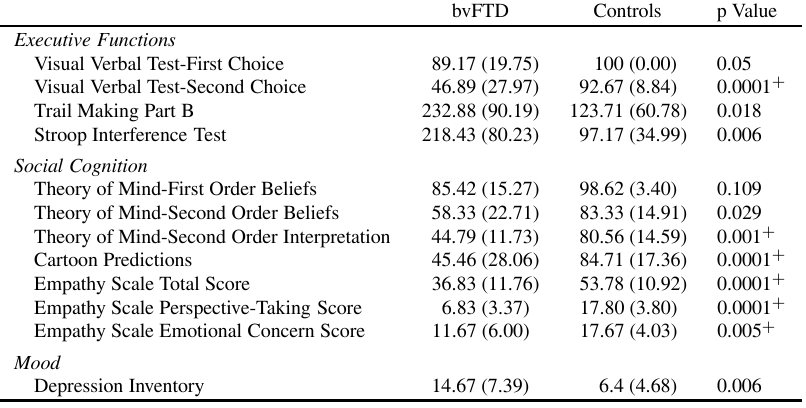
Table 3 Summary of executive function, social cognition and mood scores in the bvFTD and control samples